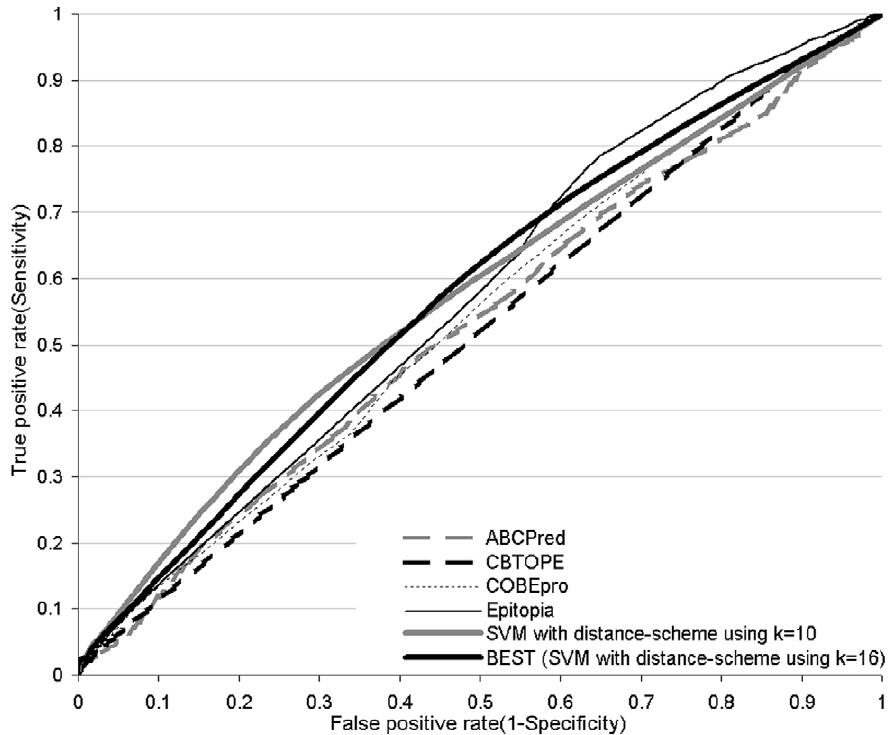
Figure 6. Receiver operating characteristic (ROC) curves of the considered B-cell epitope predictors on the SEQ194 dataset.